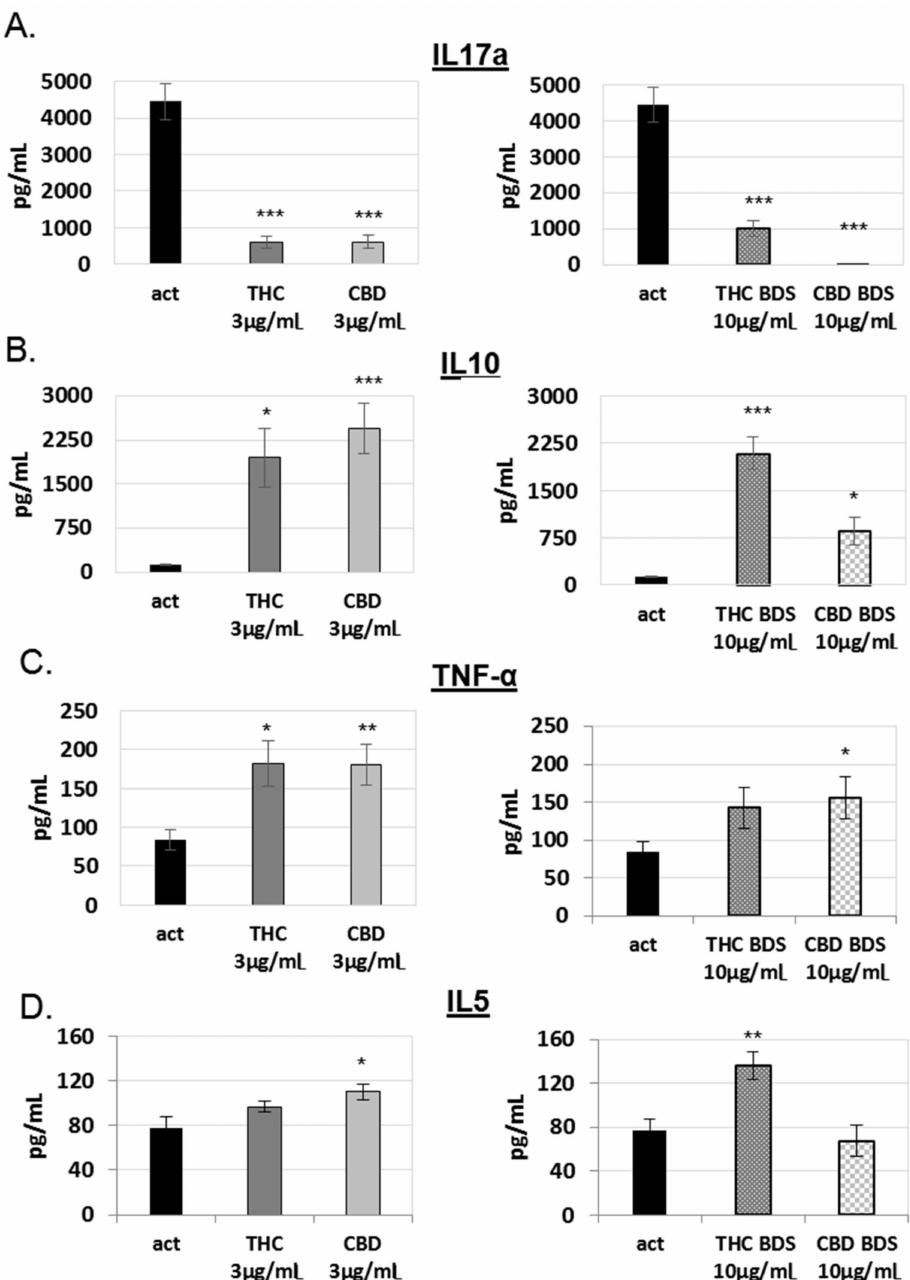
Figure 2. The influence of pure CBD/THC and cannabis extracts on cytokine secretion. Quantification of IL-17a ( A ), IL-10 ( B ), TNF α ( C ), and IL-5 ( D ) secretion from C57bl/6 splenocytes activated for 4 days which were treated with cannabinoids/cannabis, was performed using enzyme-linked immunosorbent assay on culture medium of activated cells. Data are summarized for five independent experiments for CBD BDS and six independent experiments for the other treatments. Results are expressed as mean + SEM. p Value as compared to activated control cells *, <0.05; **, <0.001; ***, <0.0001, act: activated splenocytes, THC: D9 tetrahydrocannabinol, CBD: cannabidiol, BDS: Botanical Drug Substance. Overall, these results show that the cannabinoids CBD and THC have an inhibitory effect on lymphocyte activation, which is associated with a reduction in the secretion of the inflammatory IL-17 cytokine and an elevation in the secretion of the regulatory cytokine